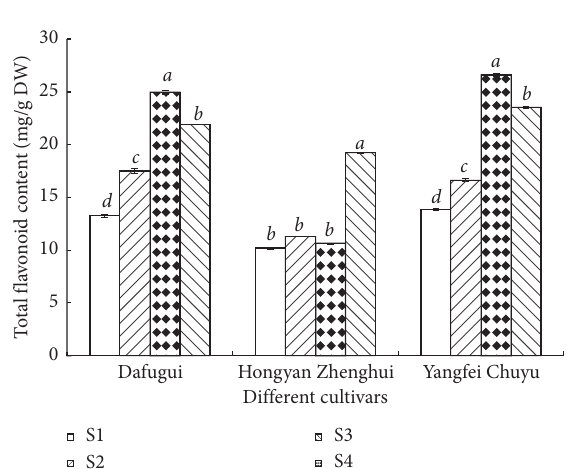
Figure 6: Total phenol content of developmental P. lactiflora petals (mg/g DW). Different letters within each cultivar indicated sig- nificant differences at 5% level.